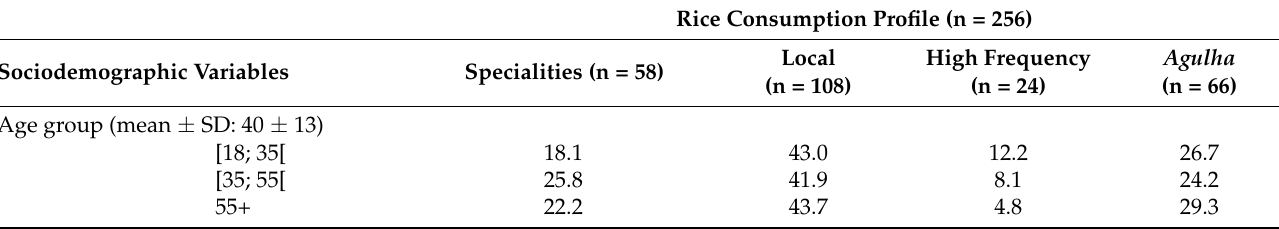
Table 5. Sociodemographic characterization of the rice consumption profiles according to age group, sex, education level, and monthly household